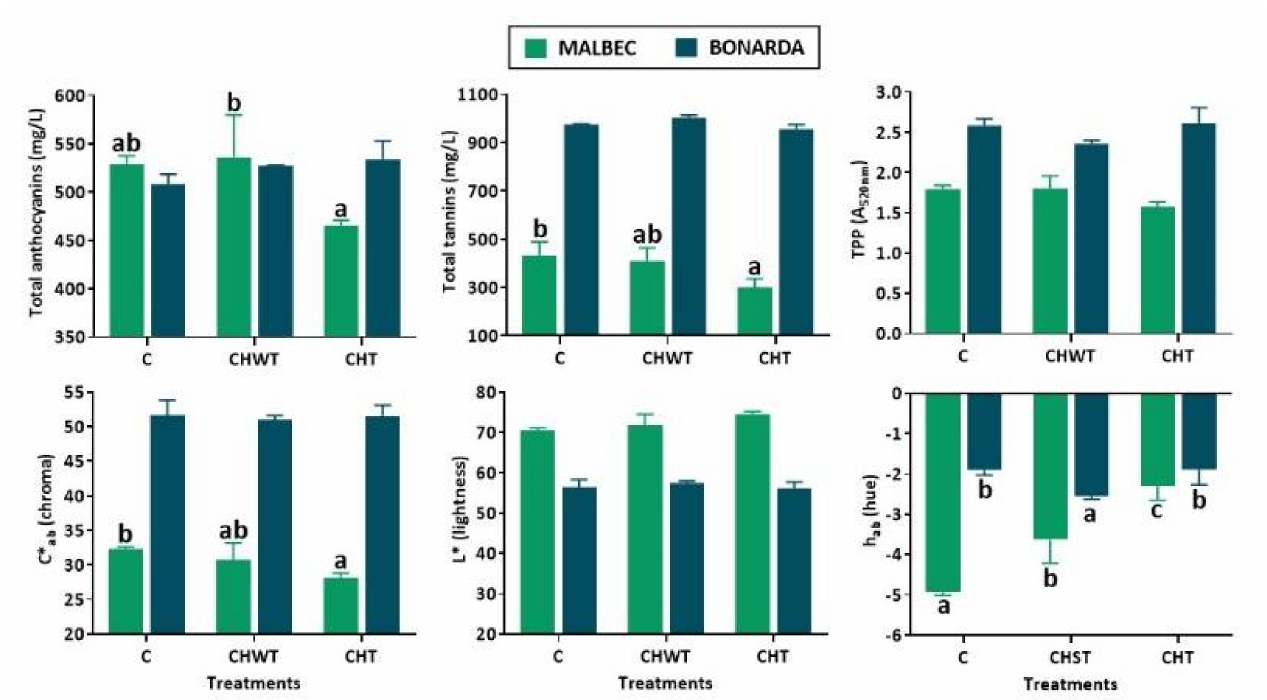
Figure 1. Global phenolic compositions and color parameters of Malbec and Bonarda wines, obtained by applying different vine-shoot treatments during winemaking. Different letters for each variety indicate significant differences between treatments (Tukey’s HSD test, p < 0.05). C, control; CHWT, untoasted vine-shoot chips; CHT, toasted vine-shoot chips; TPP, total polymeric